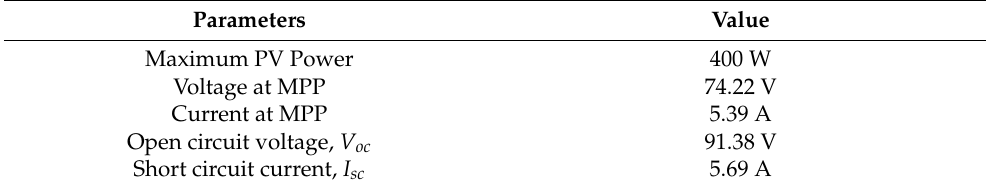
Table 2. Specification of the utilized PV Module.